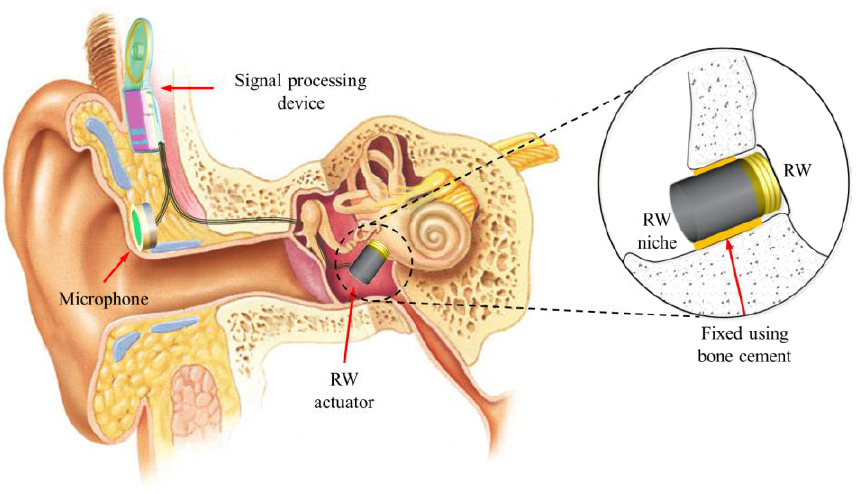
Figure 1. Diagram of the round-window-drive (RW-drive) implantable middle-ear hearing aid [18].